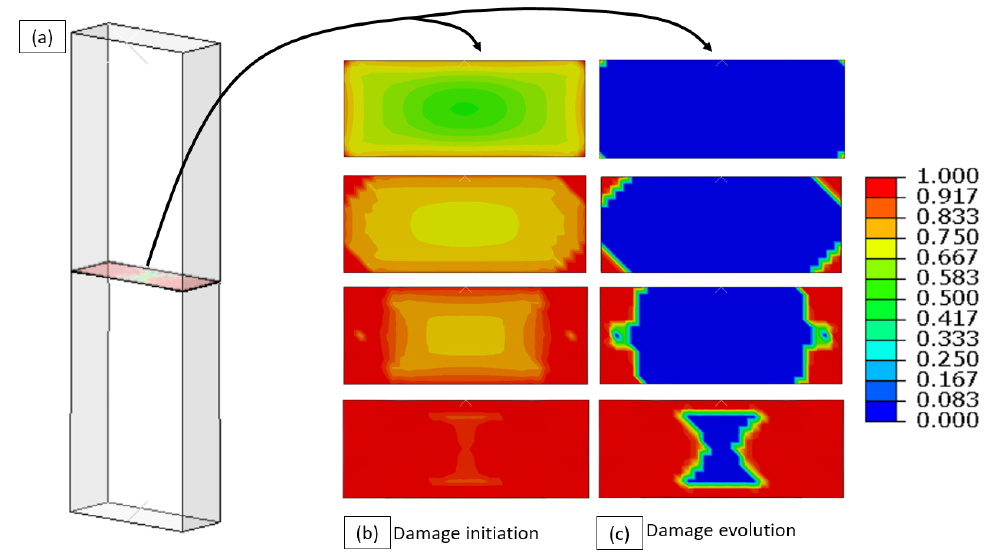
Figure 20. ( a ) The bonded surface in the computation bi-material specimen, ( b ) evolution of the